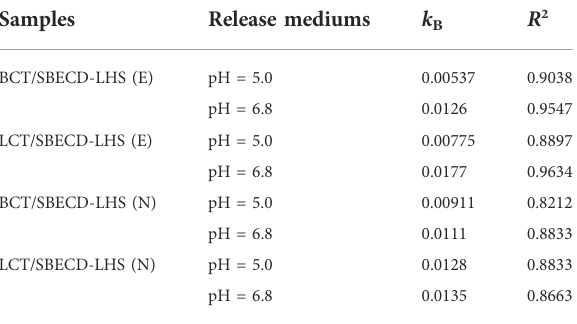
TABLE 3 Kinetic parameter of Bhaskar model of hybrids in pH = 5.0 and pH = 6.8 solutions.